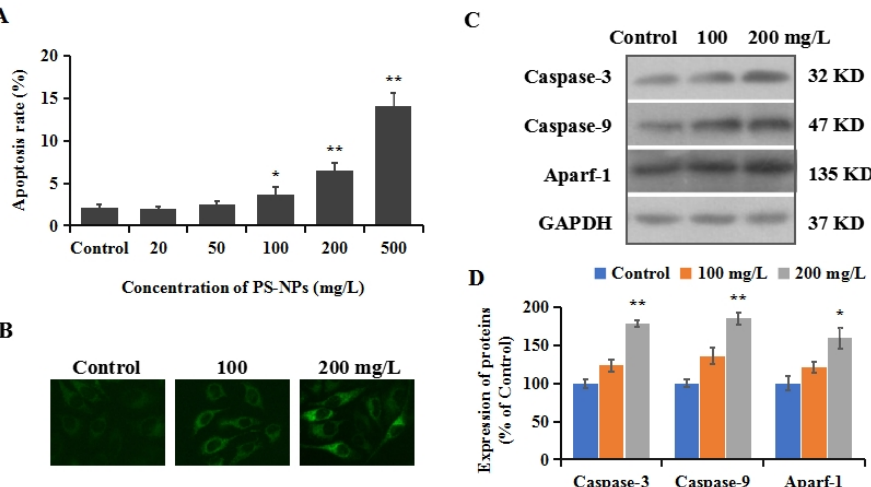
Figure 2. The apoptosis induced by PS-NPs in SHSY-5Y cells. ( A ): SHSY-5Y cells were treated with different concentrations (20, 50, 100, 200, and 500 mg/L) of PS-NPs for 24 h. Then, apoptosis was detected with the annexin V-FITC/PI kit. ( B ): After the treatment of 100 and 200 mg/L of PS-NPs for 24 h, the localization of Cyc-c was observed by immunofluorescence. ( C ): The expressions of caspase-3, caspase-9, and Aparf-1 were measured with Western blotting. ( D ): The expressions of proteins were quantified. In the control group, SHSY-5Y cells were only treated with medium. * p < 0.05 and ** p < 0.01, compared to the control.